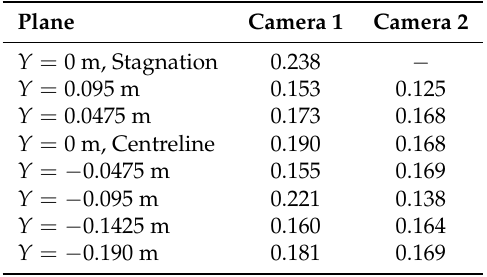
Table 1. Root Mean Squared pixel deviations for each plane and camera for the PIV set up.